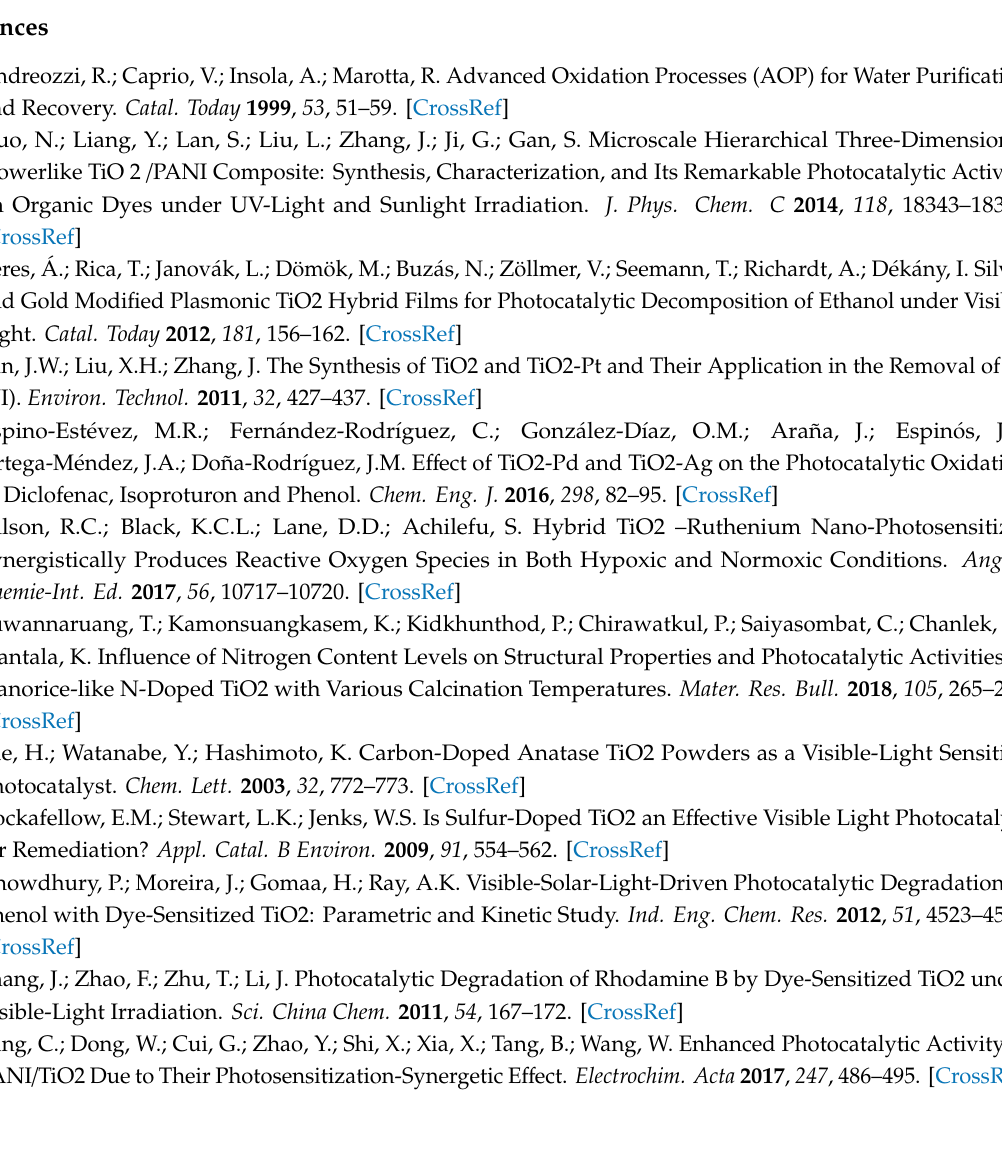
Figure S1: The Tauc plots for TiO 2 , PANI and PANI-TiO 2 , Figure S2a–d: TEM microscopy analysis of PANI / TiO 2 composite, Figure S3: Photocatalytic activity of TiO 2 , PANI and PANI-TiO 2 in reaction of phenol degradation under UV-Vis light irradiation, Figure S4: Photocatalytic activity of TiO 2 , PANI and PANI-TiO 2 in reaction of phenol degradation under Vis > 400 nm light irradiation, Figure S5: Photocatalytic activity of TiO 2 , PANI and PANI-TiO 2 in reaction of phenol degradation under Vis > 420 nm light irradiation, Figure S6: Toluene degradation in time. The e ff ect of irradiation source with maximum wavelength emission at 380 nm, 415 nm and 460 nm for a) TiO 2 and b) PANI-TiO 2 hybrid nanocomposite, Figure S7a–d: SEM images of gypsum surface modified with PANI-TiO 2 , Figure S8: Toluene degradation in time for gypsum, gypsum + 10% TiO 2 , and gypsum + 10% PANI-TiO 2 using a) LEDs with a maximum wavelength emission at 380 nm, b) LEDs irradiation source with a maximum wavelength emision at 460